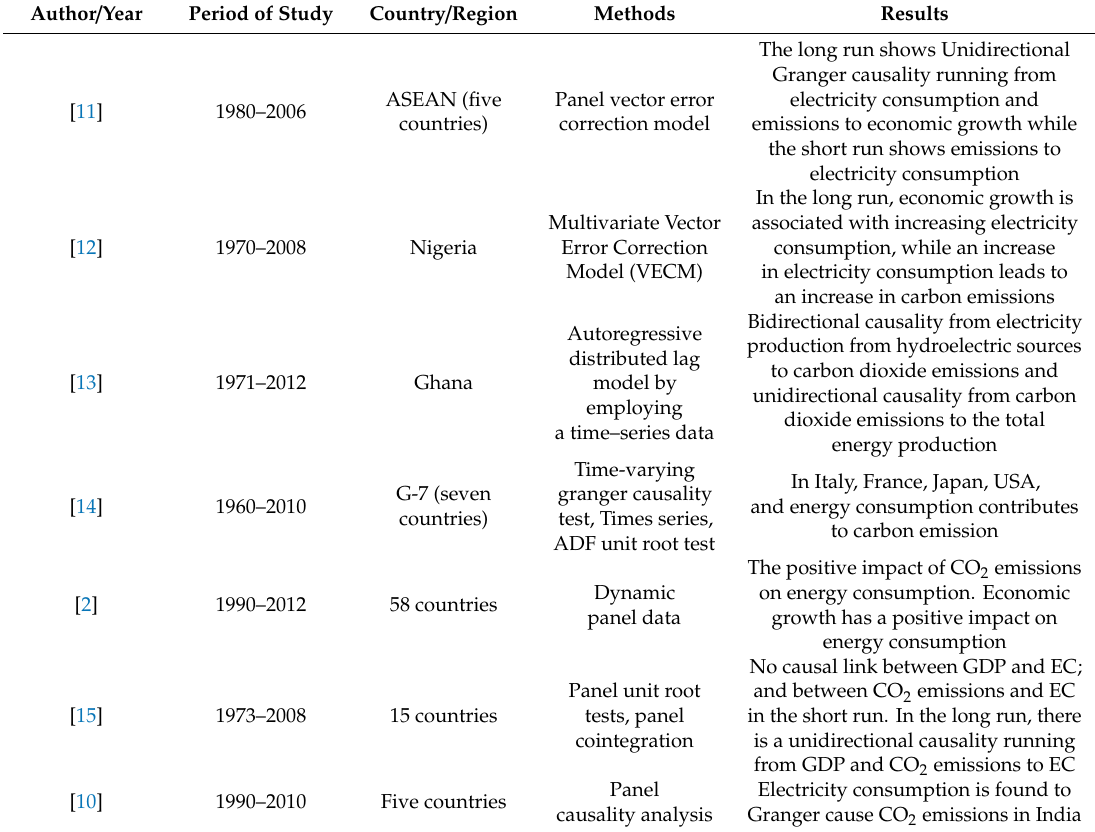
Table 1. Empirical studies on the relationships between CO 2 emissions, energy consumption, and economic